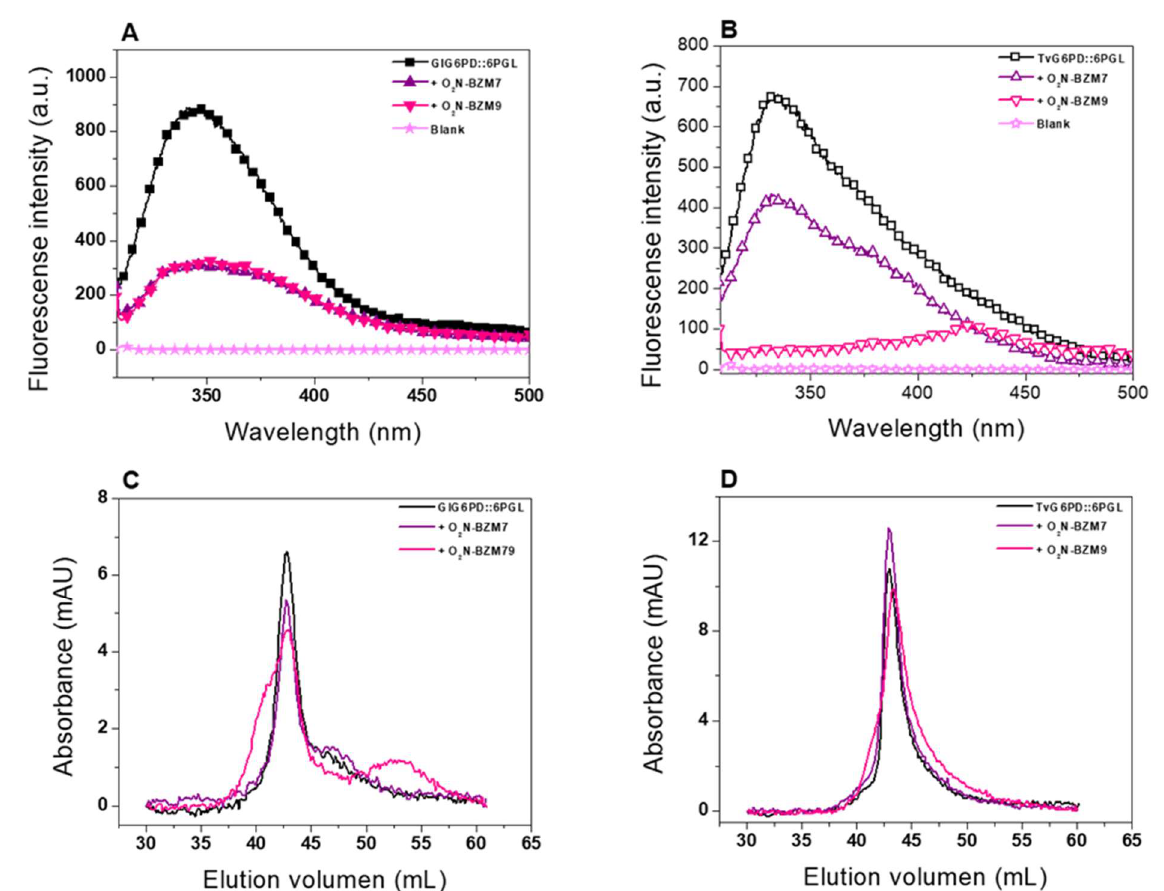
Figure 6. Spectroscopic and chromatographic characterization. ( A ) Intrinsic fluorescence emission spectra of GlG6PD::6PGL enzyme and ( B ) TvG6PD::6PGL in the absence and presence of the ben- zimidazole compounds. The values obtained from the buffer without protein corresponded to the blank and were subtracted from the spectra obtained with protein. Data are presented as the mean of three experiments. ( C ) Gel filtration chromatography of GlG6PD::6PGL and ( D ) TvG6PD::6PGL in the absence or presence of the compounds. The enzymes (0.5 mg/mL) were incubated at 37 °C for 2 h with each of the benzimidazole compounds and then loaded onto a Sephacryl TMS-200 HR HiPrepTM 16/60 column.